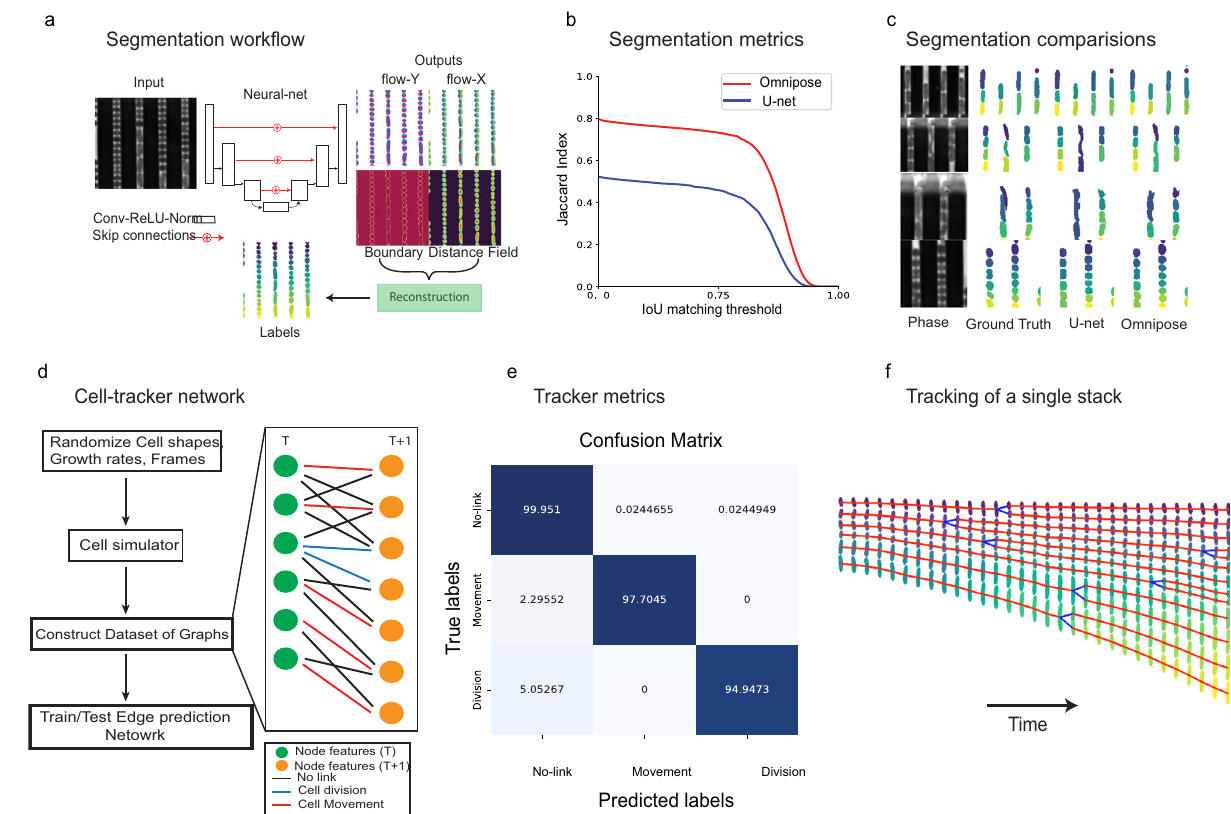
Fig. 2 | Analysis. a Omnipose network showing network structure, inputs, and outputstotheneuralnetworkandreconstructionofoutputtogeneratecellmasks. b Quanti fi ed performance of cell segmentation in mother-machine devices. Aver- age precision vs IOU threshold plot for mixed-species dataset. The IOU threshold de fi nes valid matching between predicted mask and ground-truth masks, 0.5 indicating half the pixels were correctly matched and 1 indicating pixel perfect